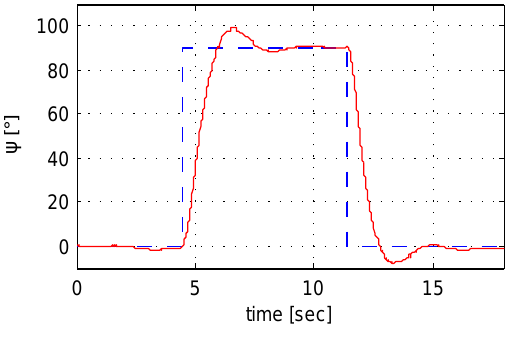
Figure 4. Yaw angle step